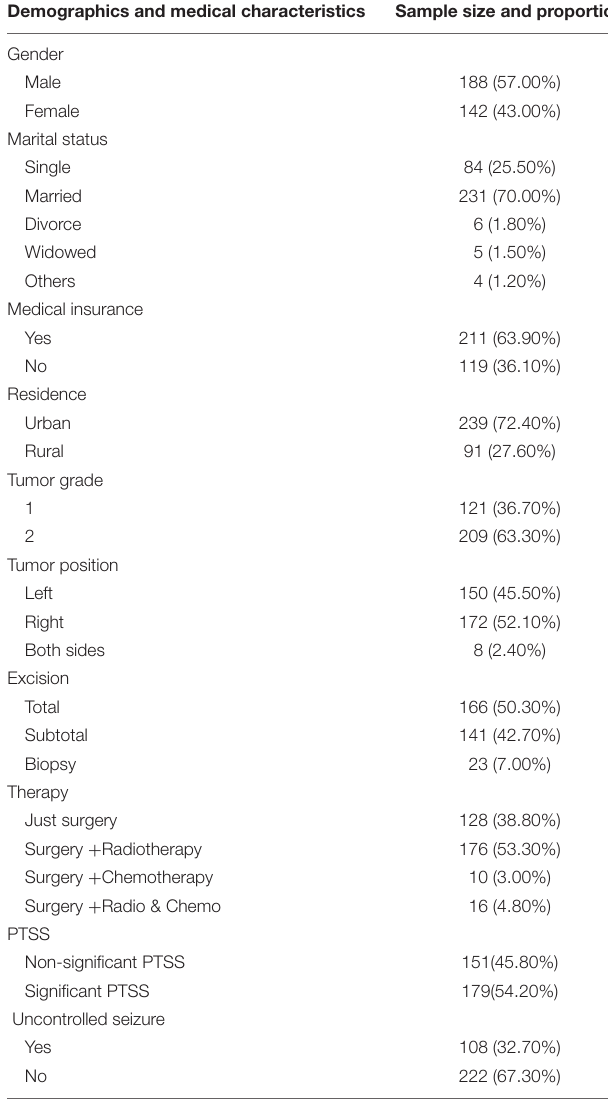
TABLE 1 | Patient demographics and medical